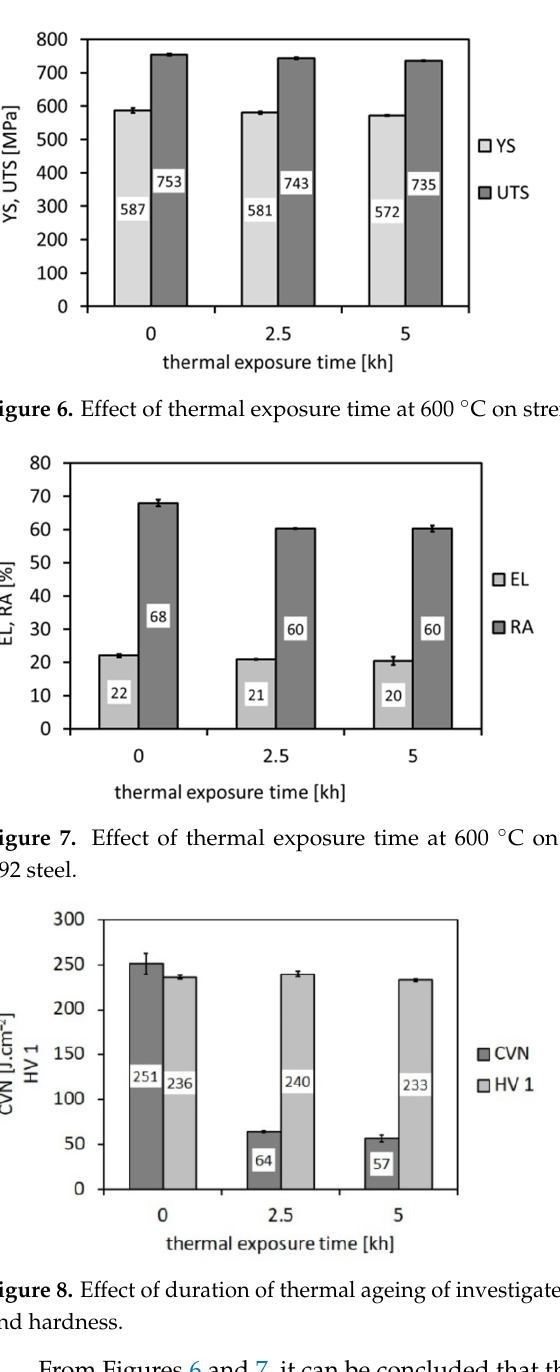
Figure 8. Effect of duration of thermal ageing of investigated P92 steel at 600 °C on impact tough- ness and hardness.